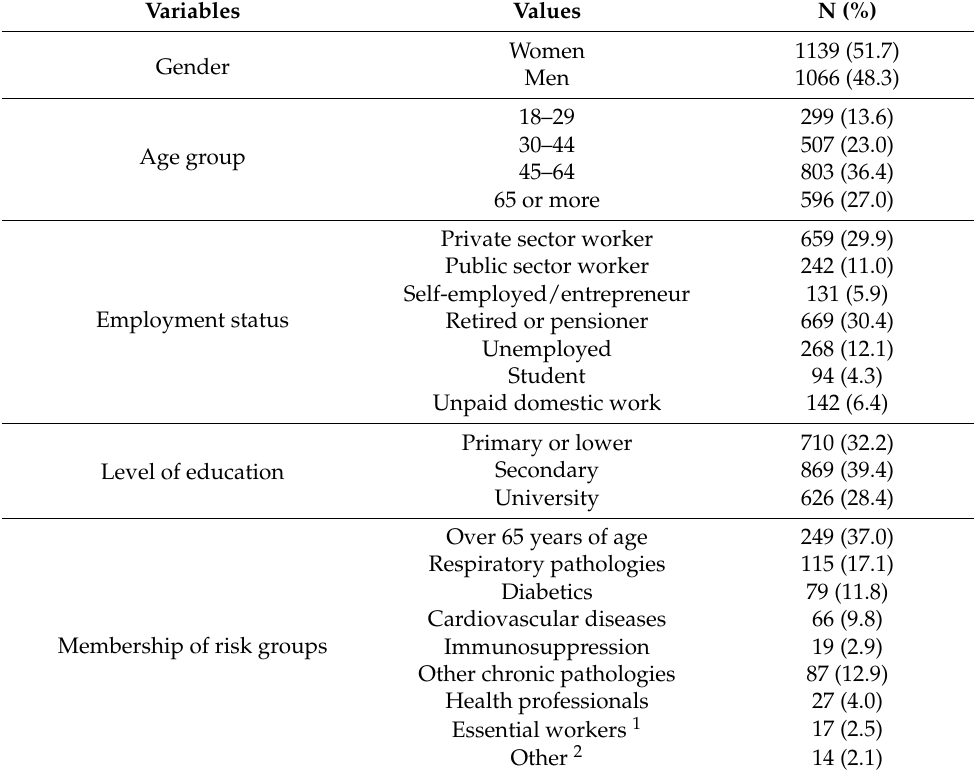
Table 1. Socio-demographic characteristics of the study